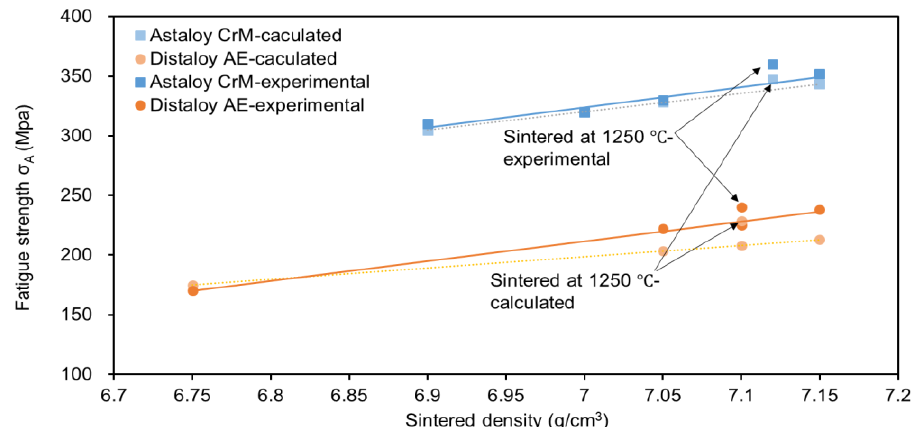
Figure 9. Calculated fatigue strength by the modified Murakami model as a comparison with the experimental results of fatigue tests.